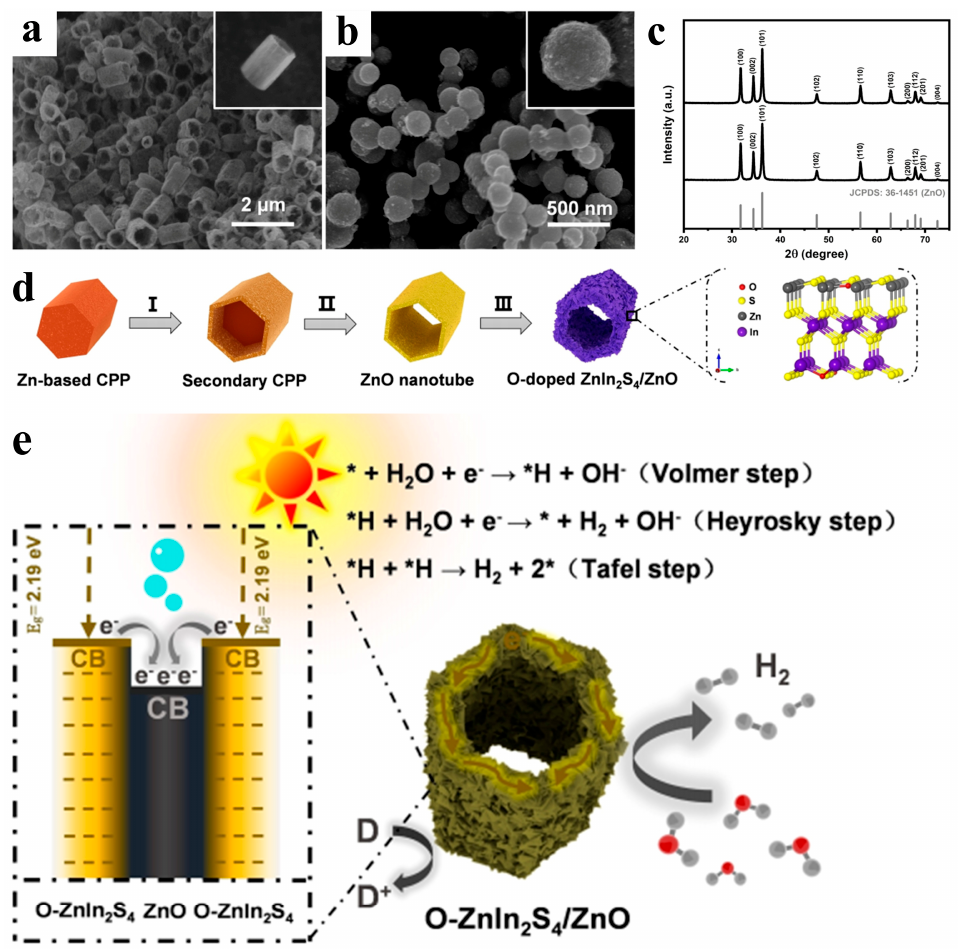
Figure 18. ( a , b ) The FESEM images and ( c ) the powder XRD patterns of CPPs-derived hollow ZnO microtubes and microspheres. ( d ) The schematic illustration of the formation for the hollow O-doped ZnIn 2 S 4 /ZnO microtubes. ( e ) The illustration of the hydrogen evolution reaction on O-ZnIn 2 S 4 /ZnO-T heterosurfaces. Reproduced with permission from Ref. [86].